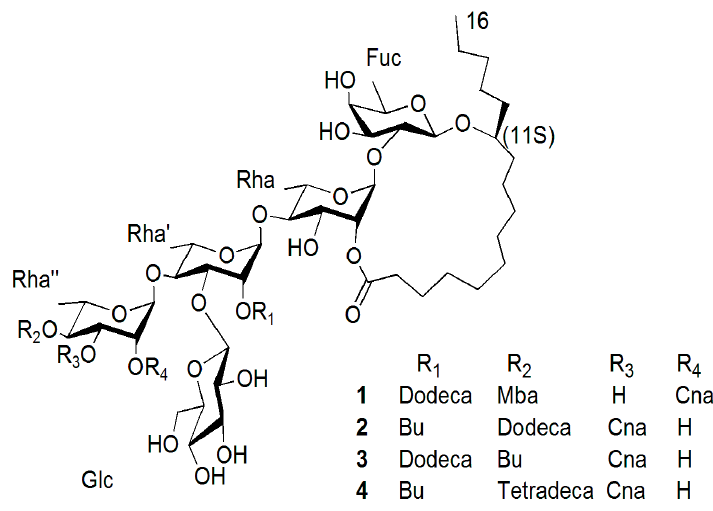
Figure 1. Structures of compounds 1 – 4 .